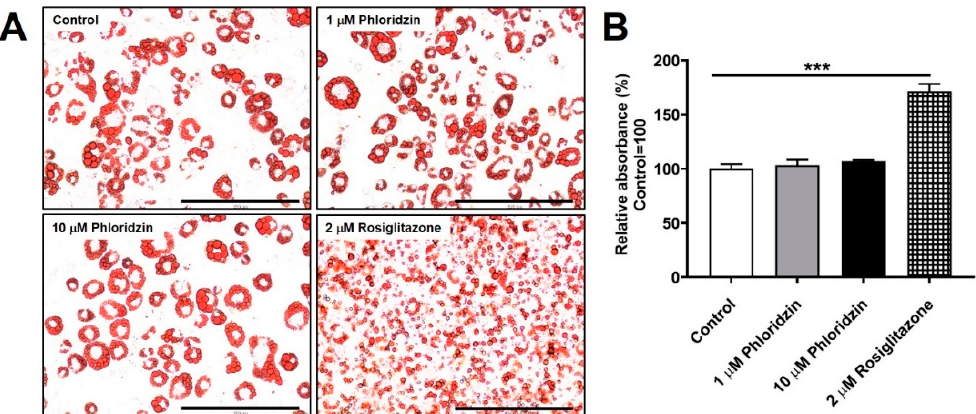
Figure 7. Phloridzin does not accelerate lipid accumulation. ( A ) 3T3-L1 preadipocytes were differentiated into mature adipocytes in the presence of phloridzin or rosiglitazone. The extent of lipid droplets was monitored by Oil Red O staining on day 6 of differentiation. Images of fat accumulation were acquired using an EVOS FL Imaging System. ( B ) For quantification of lipid accumulation, Oil Red O dye was eluted by incubation with isopropanol and the absorbance was measured at 490 nm using a microplate reader. All experiments were independently repeated at 3 times. Results are presented as mean ± SEM. Data were analyzed using two-tailed unpaired t -test. *** p < 0.001 compared to the control group. Scale bar: 200 μ m.